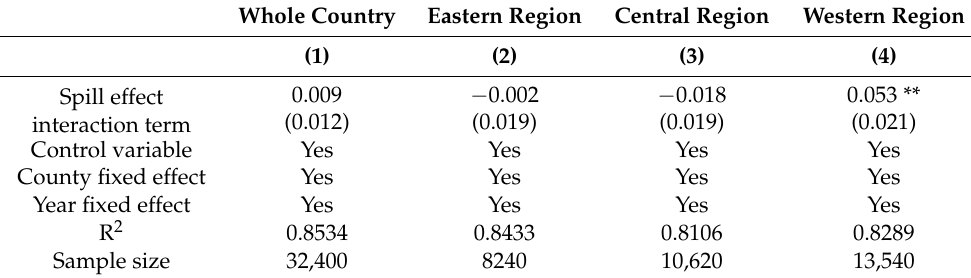
Table 7. Spillover effect